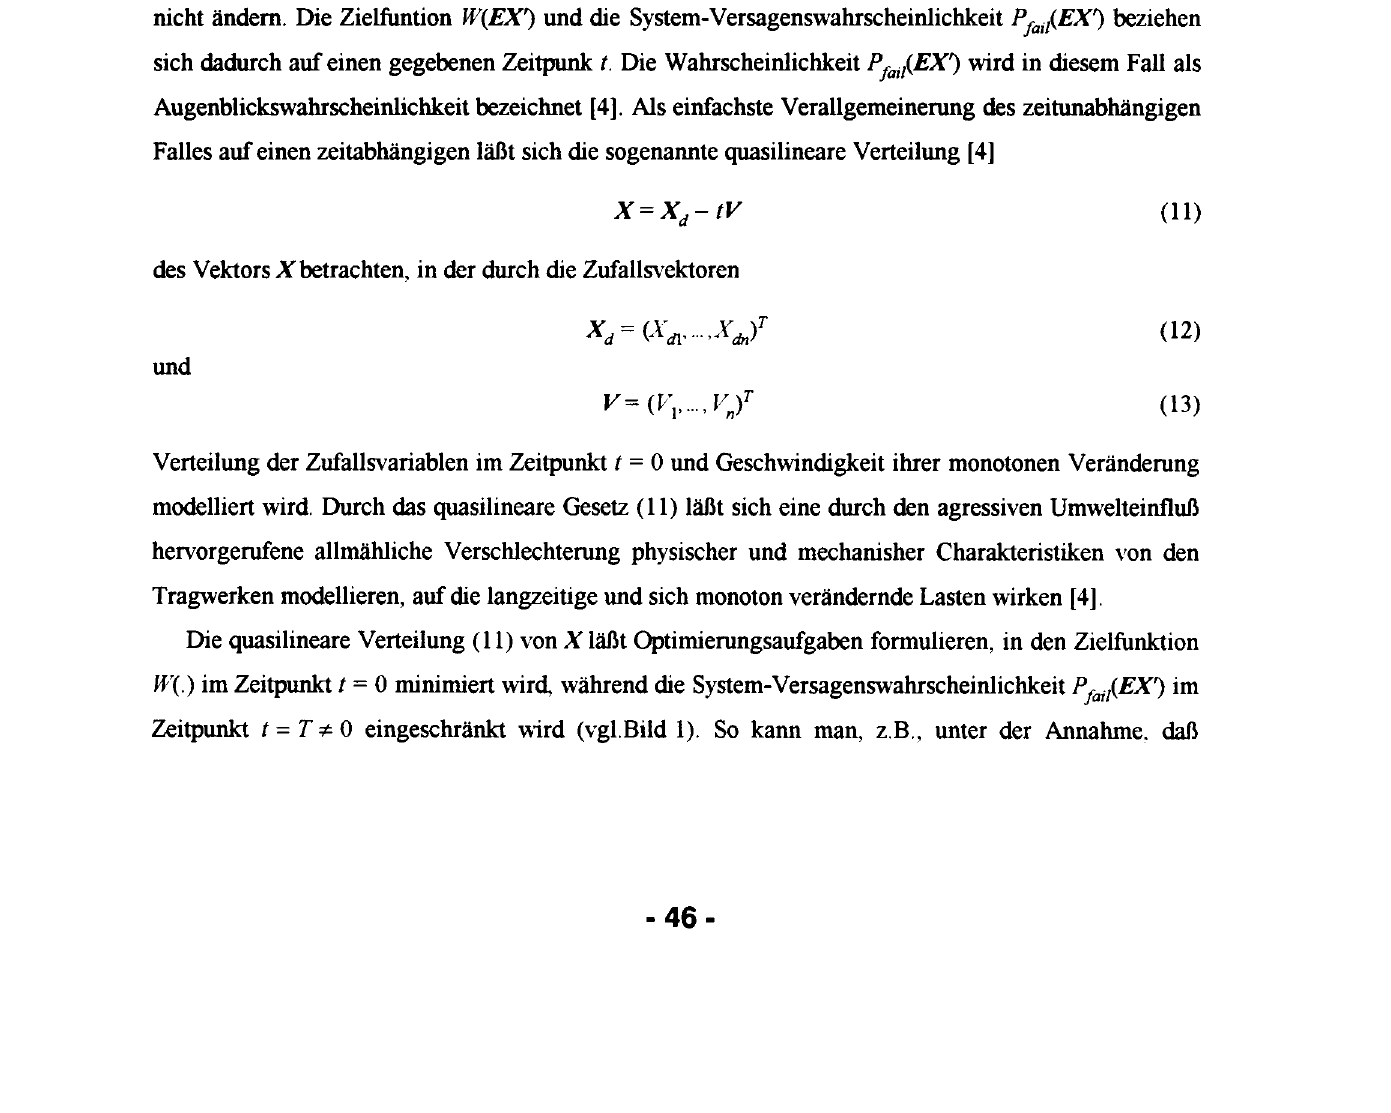
unterschiedlichen